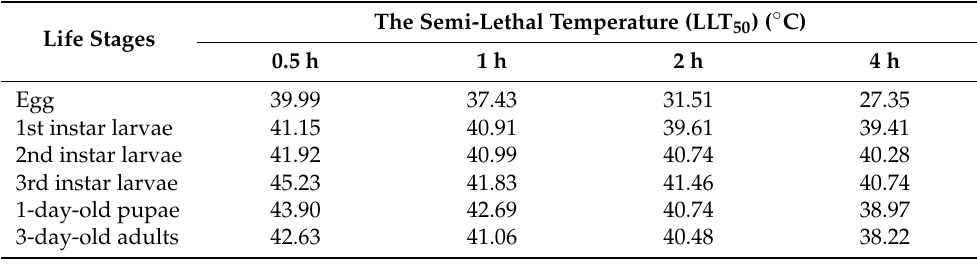
Figure 3. Effect of extreme high temperature and exposure time on the mortality rate of different developmental stages of Bactrocera tau . ( A ) Eggs, ( B ) 1st instar larvae, ( C ) 2nd instar larvae, ( D ) 3rd instar larvae, ( E ) 1-day-old pupae, and ( F ) 3-day-old adults. Bars represent mean ± SE values. Differ- ent letters denote significant differences among exposure times at the same treatment temperature (ANOVA, p < 0.05). Table 3. Predicted LLT 50 ( ◦ C) of different life stages of Bactrocera tau with different exposure heat temperatures and